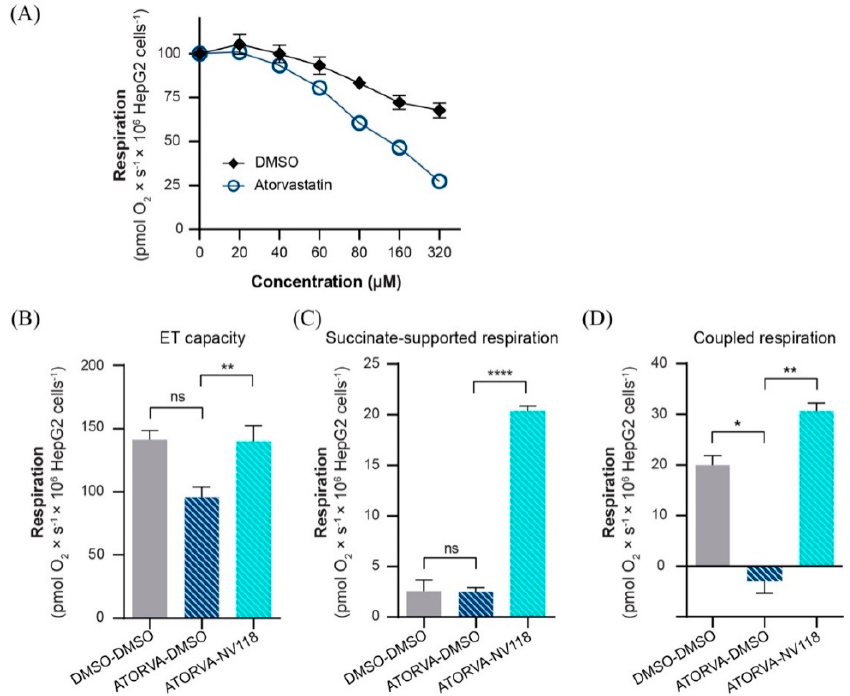
Figure 5. The effects of NV118 on statin − dependent respiratory dysfunction in HepG2 cells. ( A ) Respiration was assessed after sub-maximal uncoupling with FCCP (4 µM) followed by increasing concentrations of atorvastatin or vehicle (DMSO). NV118 effects on atorvastatin exposed HepG2 cells ( B – D ) were measured as compared to its vehicle (DMSO). As negative control of the experiment HepG2 cells were exposed only to DMSO (DMSO-DMSO). Data is expressed as mean ± SEM. One-way ANOVA with Bonferroni post hoc test was performed on antimycin-corrected data. ATORVA, atorvastatin; DMSO, dimethyl sulfoxide; ET, electron transport. ns = no significance; * p < 0.05; ** p < 0.01; **** p < 0.0001.